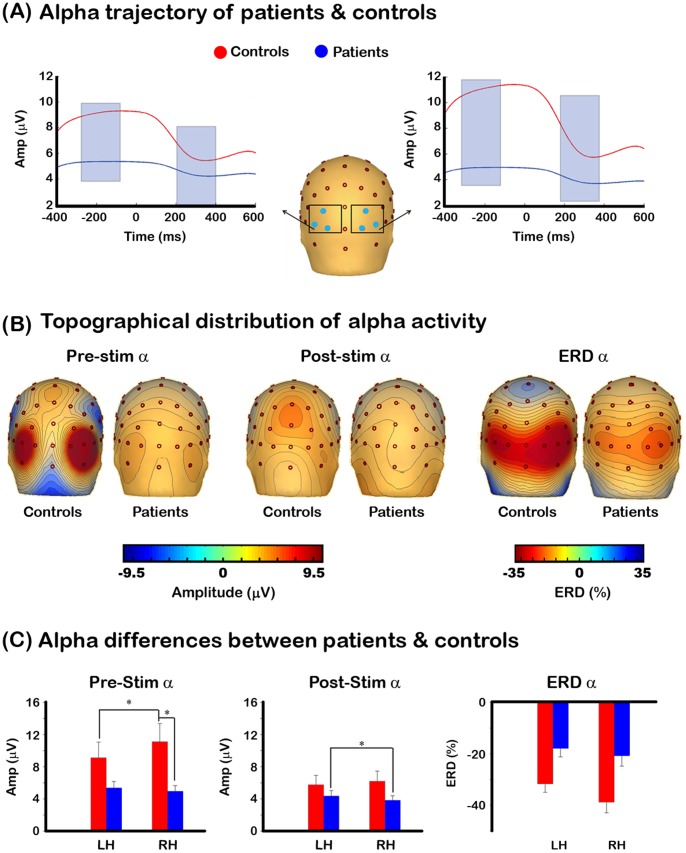
Alpha-band activity in patients and healthy controls.(A) Instantaneous alpha-band amplitude, collapsed across contrast conditions, in patients and controls. The traces correspond to the average activity between the three electrode sites illustrated in the head model (B). This figure shows the topographical distributions for each time period of interest in controls and patients. The data show a focal bilateral distribution in pre-stimulus alpha for the controls and patients (patients’ activity is substantially reduced). The post-stimulus alpha topography shows a weak parieto-occipital central distribution for the controls. The ERD topography in both groups shows a bilateral distribution with higher activity over the right hemisphere. (C) This figure illustrates alpha differences between groups. The data shows greater activity in controls vs. patients in every measure. LH = left hemisphere, RH = right hemisphere. Red traces and bar graphs correspond to activity of healthy controls, while blue traces and bar graphs correspond to activity of patients.